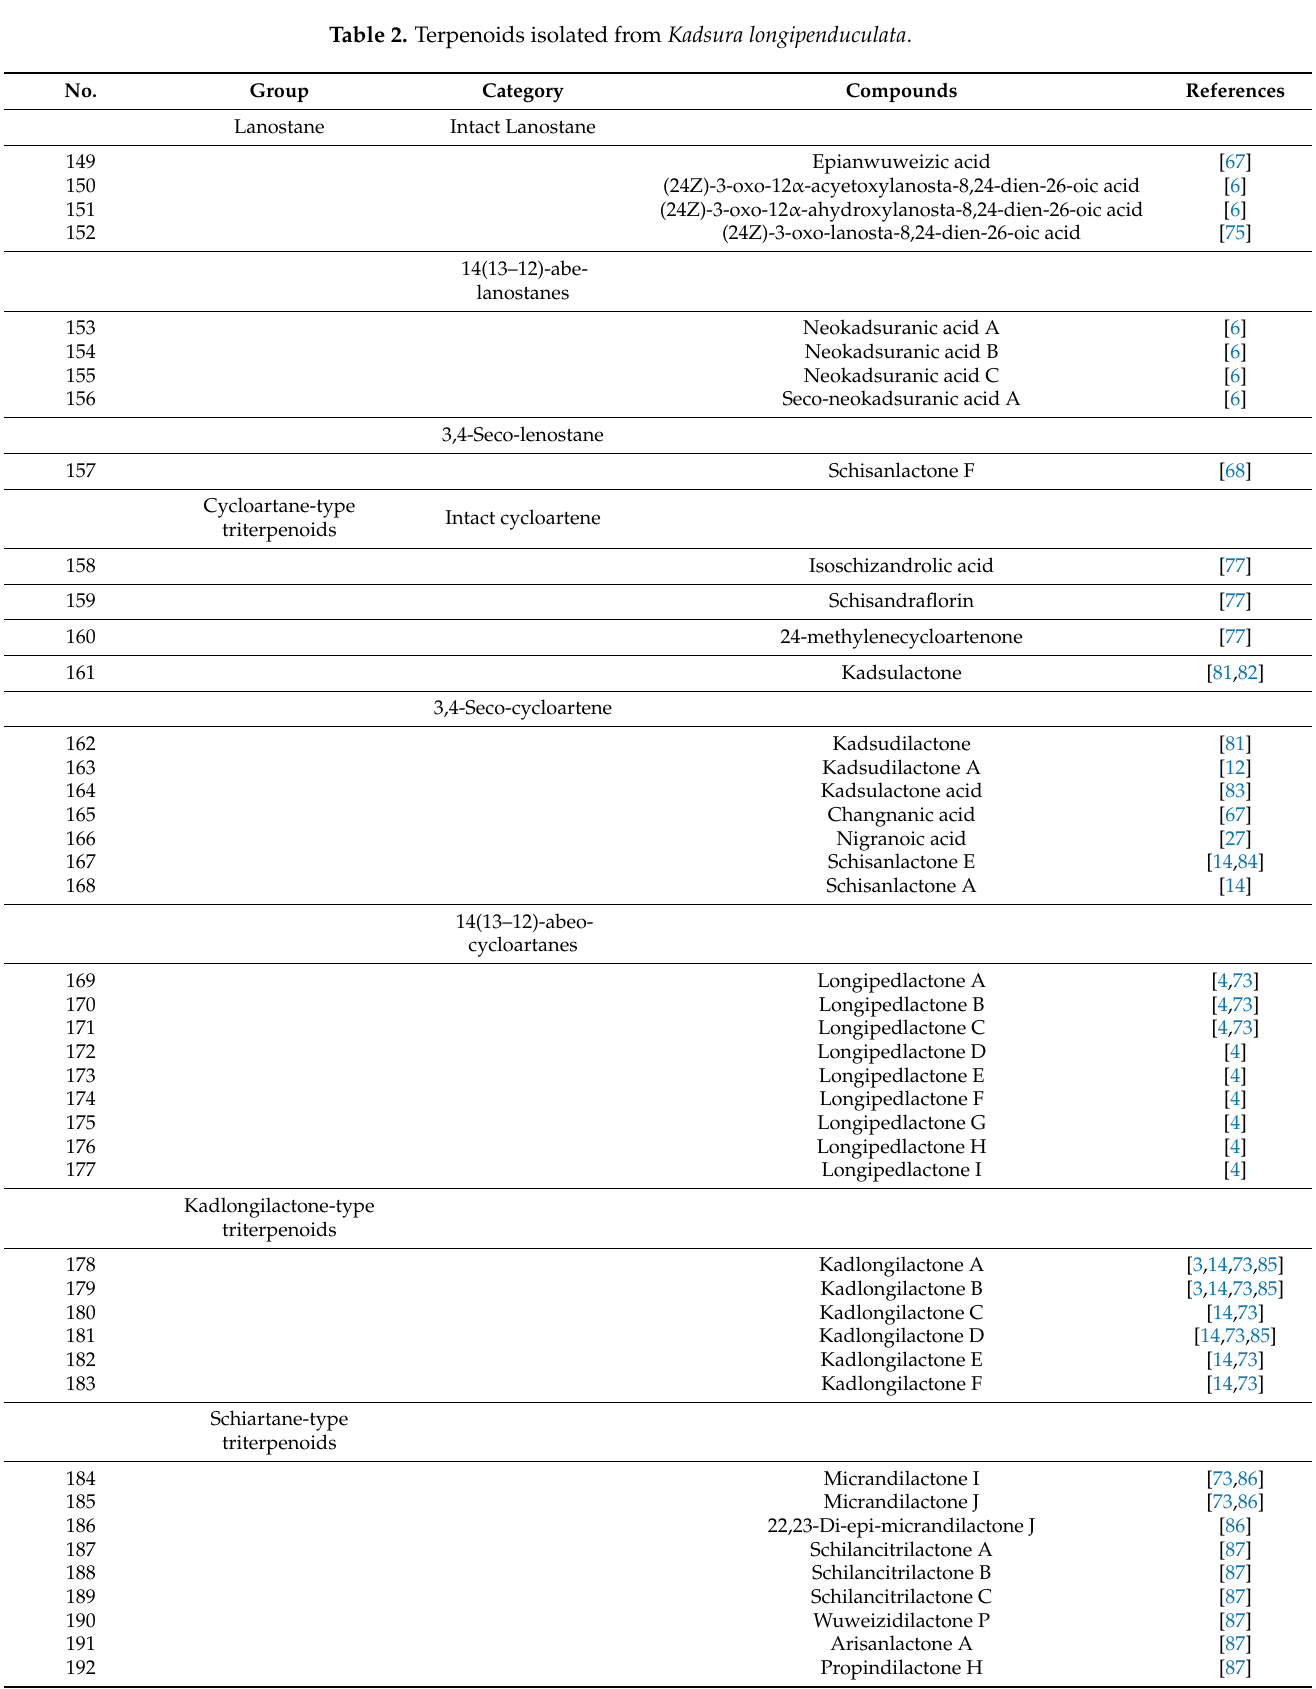
Table 2. Terpenoids isolated from Kadsura longipenduculata